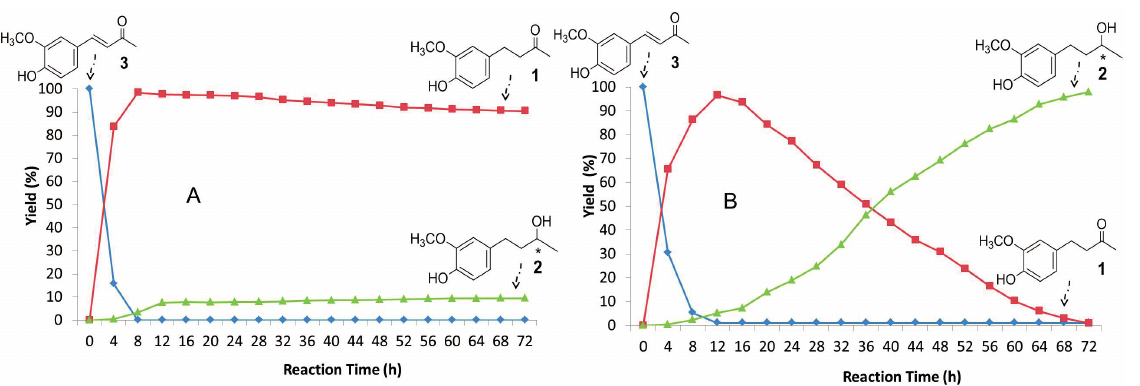
Figure 2. Time-course of the biotransformation of dehydrozingerone 3 with A. fumigatus ( A ) and A. niger ( B ). * Chiral